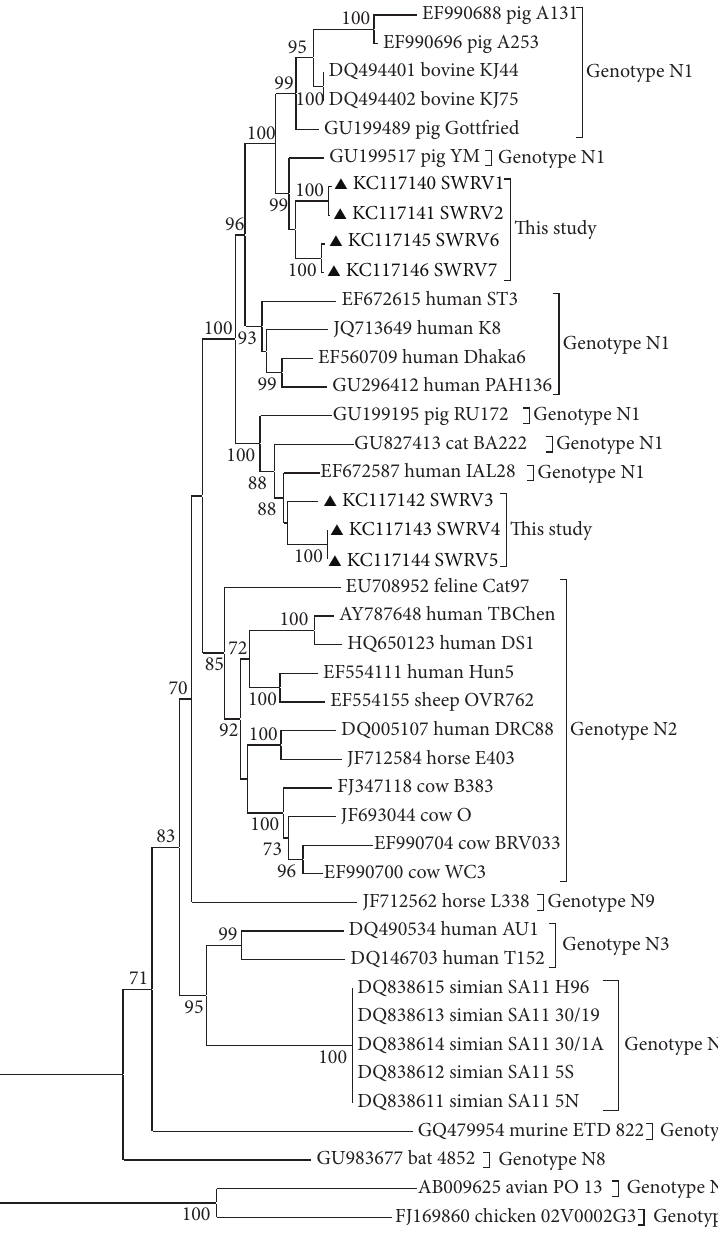
Figure 1: Phylogenetic tree constructed with the neighbor-joining method using maximum composite likelihood as substitution model for a partial region (975 bp) of the NSP2 gene of the group A porcine rotavirus of the strains SWRV1 and SWRV7 with others representing human and animal GARVs. The scale represents the number of substitutions per site. Only bootstrap values > 70% are shown. Pig strains defined in the present study are preceded by black triangles, and they are identified as accession number/host/strain/NSP2